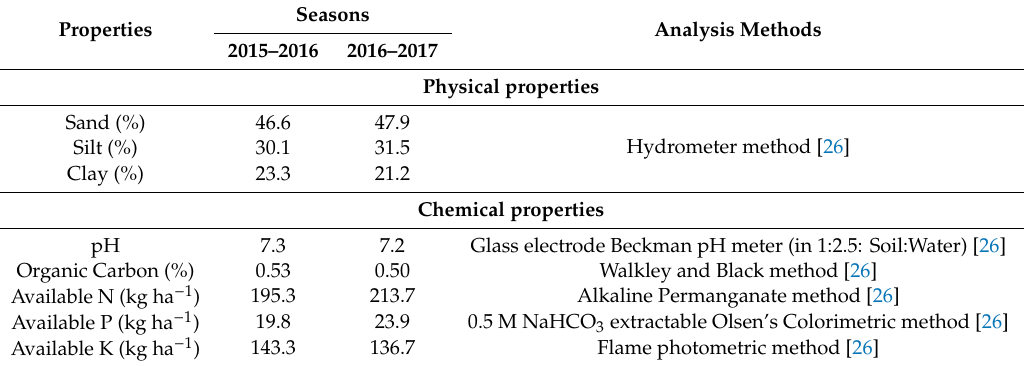
Table 1. Physical and chemical properties of the soil in the study site in 2015–2016 and 2016–2017 at the onset of each experiment (0 − 30 cm